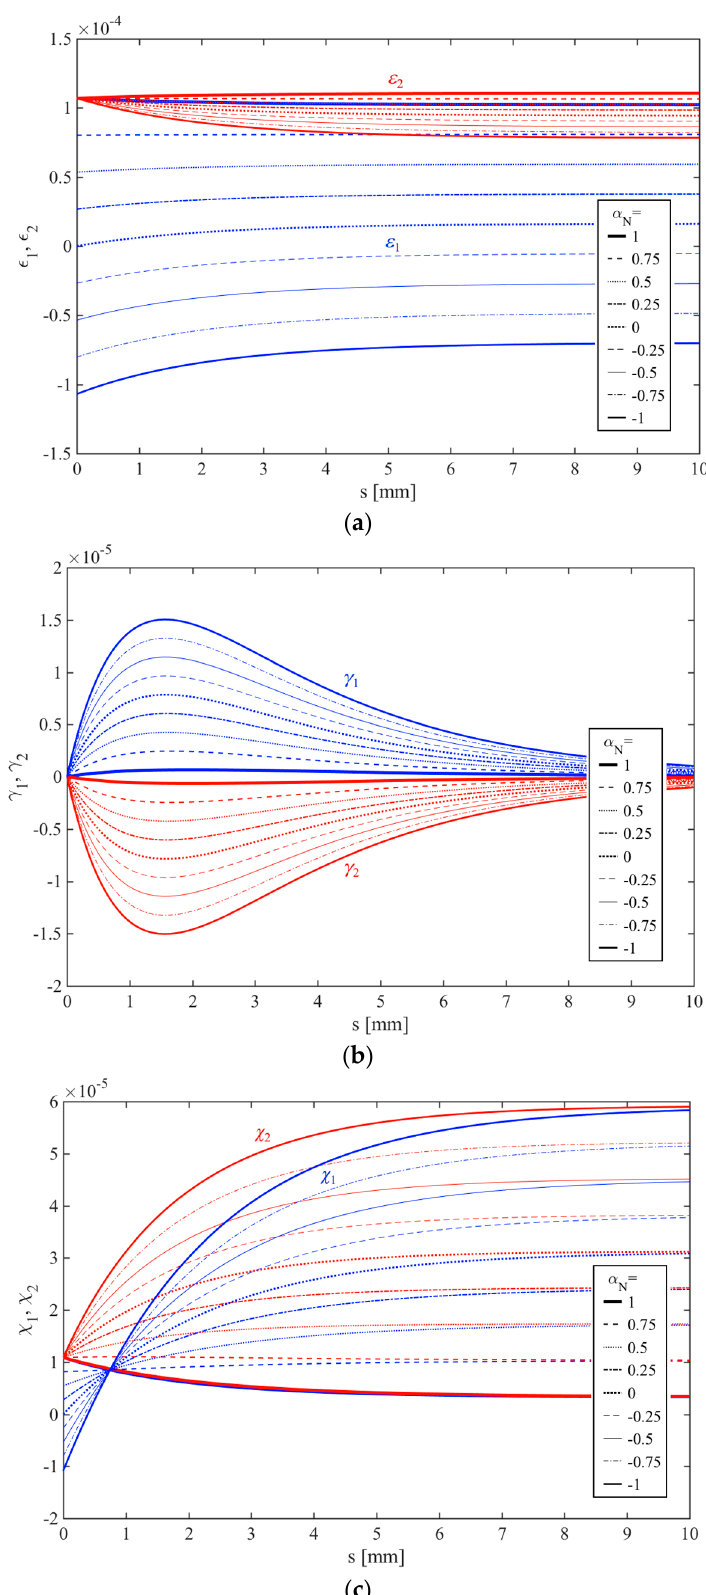
Figure 11. Effect of the axial loading on the strain field: ( a ) Axial strain; ( b ) Shear strain; ( c ) Curvature. (Orthotropic specimen).